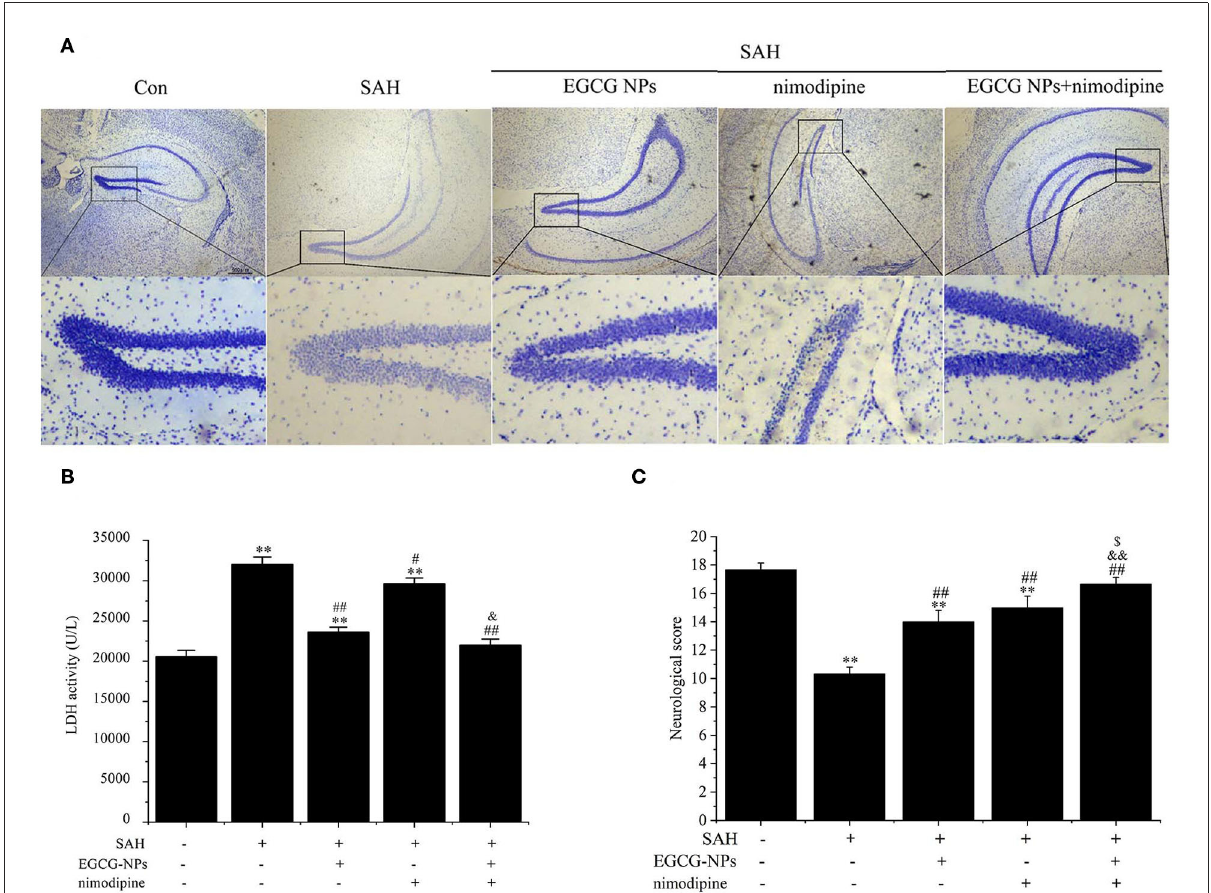
FIGURE8 Cotreatment of EGCG-NPs and nimodipine significantly improves the pathological changes after SAH. Representative micrographs of Nissl staining in the hippocampal DG region, scale bar = 500 µ m (A) . LDH levels after SAH (B) . Neurological deficits after SAH (C) . Results are presented as the means and standard deviations of the results of three independent experiments. ** P < 0.01 vs. Sham; # P < 0.05 vs. SAH, ## P < 0.01 vs. SAH; & P < 0.05 vs. EGCG, && P < 0.01 vs. EGCG; $ P < 0.05 vs. nimodipine.